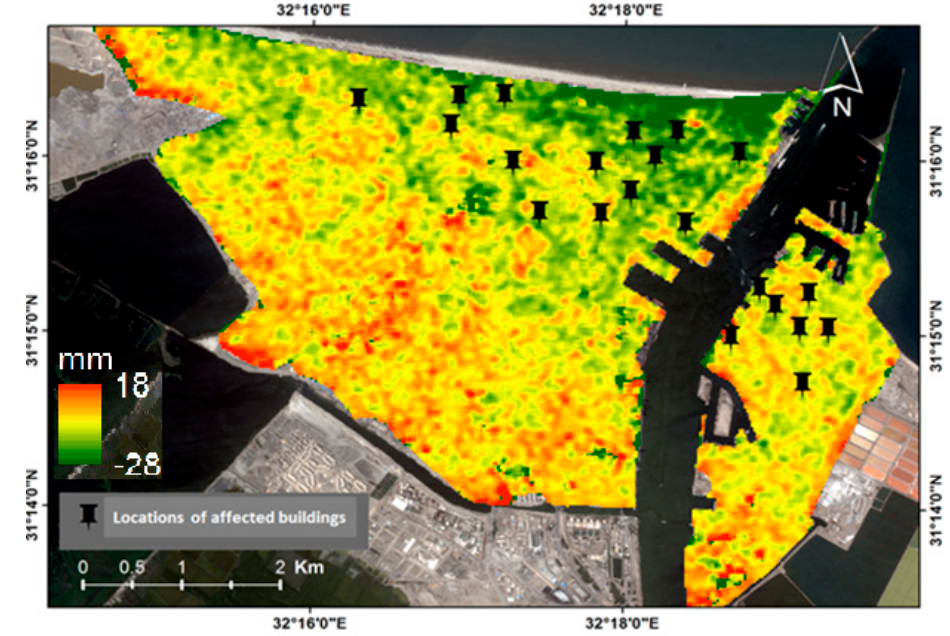
Figure 17. Land-Subsidence map showing the locations of the affected buildings.